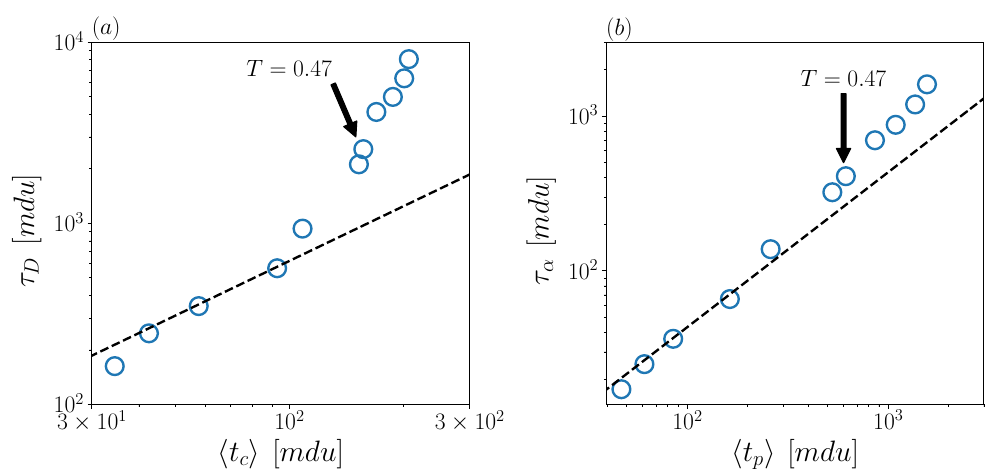
t c and ( b ) τ α versus (cid:104) (cid:105)